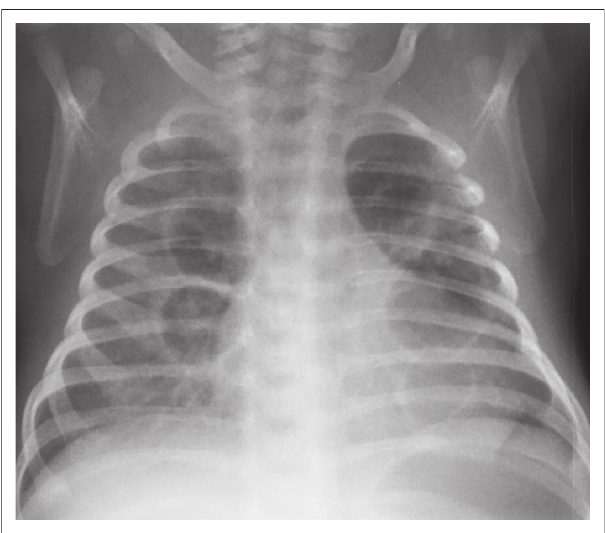
FIGURE 2: Infant girl with HIV infection and chronic PCP pneumonia. Frontal chest radiograph shows cystic changes in both lungs as a long term complication.